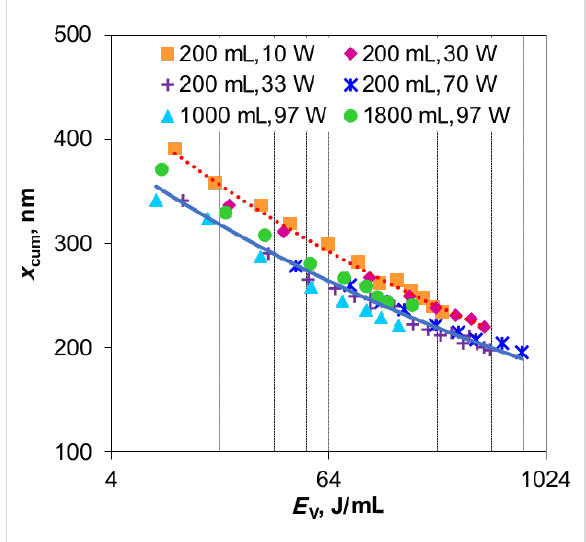
Figure 4: Aggregate size of P25 as a function of ultrasonic energy density performed by two ultrasonic devices, Hielscher UP100H (red dot) and Topas UDS751 (blue